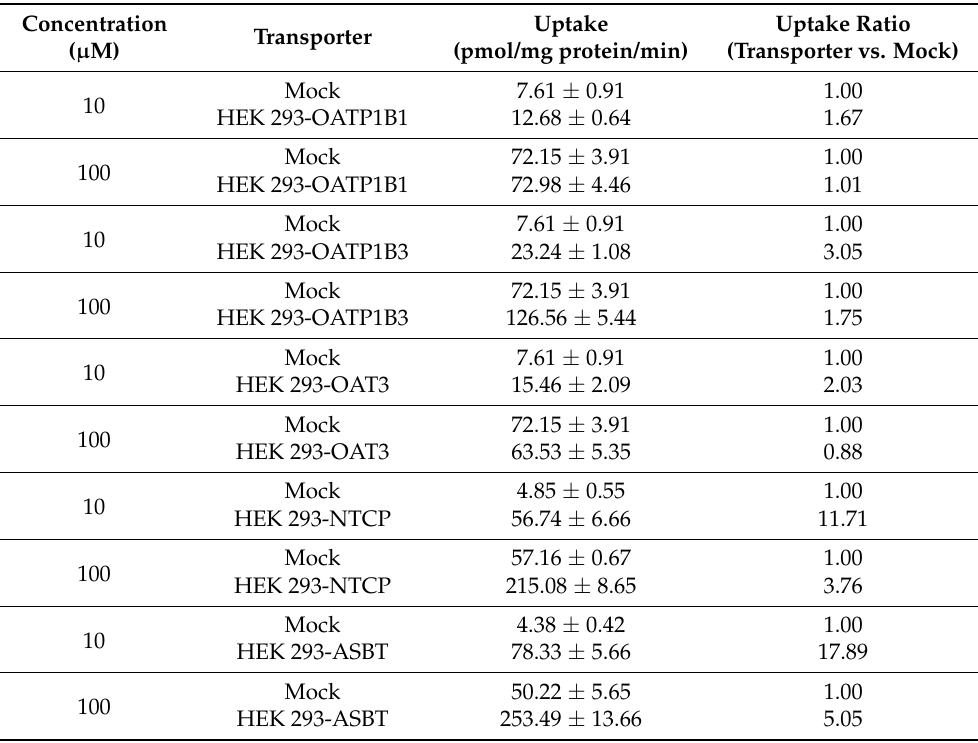
Table 1. The uptake transport rate of MT921 (10 µ M and 100 µ M) in HEK 293-OATP1B1, -OATP1B3, -OAT3, -NTCP, -ASBT, and mock cells. Uptake Uptake Concentration Transporter (pmol/mg protein/min) ( µ M)